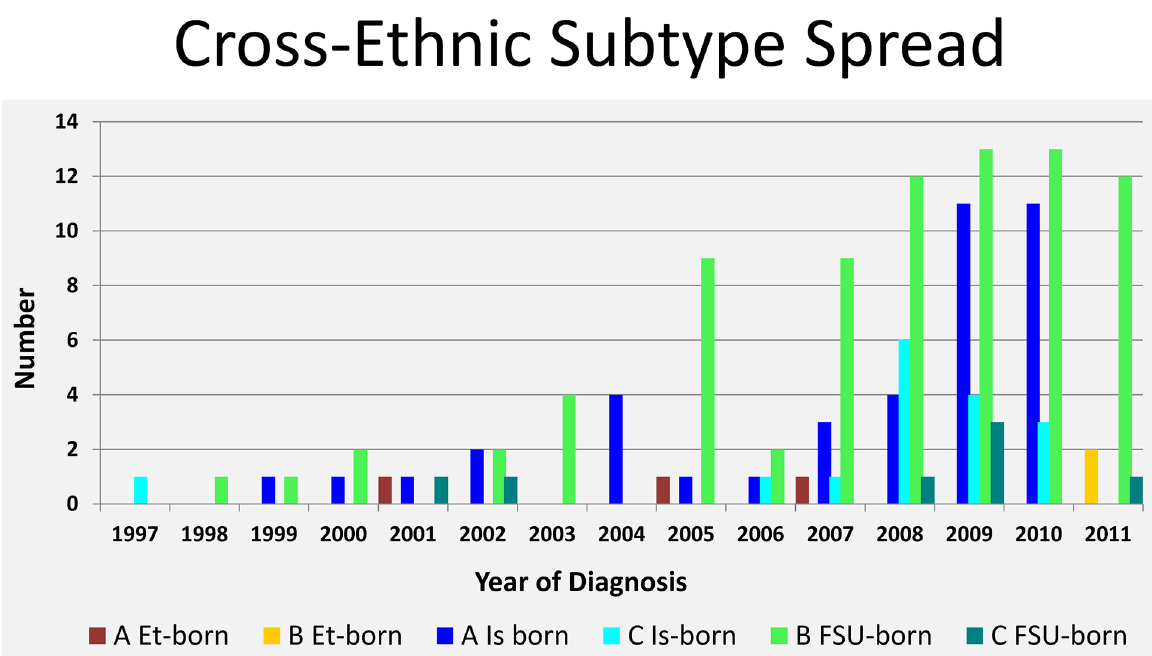
Fig 1. Cross-ethnic subtype spread. Number of individuals diagnosed each year demonstrating cross ethnic spread of HIV, including subtype A or B in Ethiopian born, subtype A or C in Israeli-born, and subtype B or C in FSU immigrants. Et, Ethiopia; FSU, Former Soviet Union; Is, Israel.